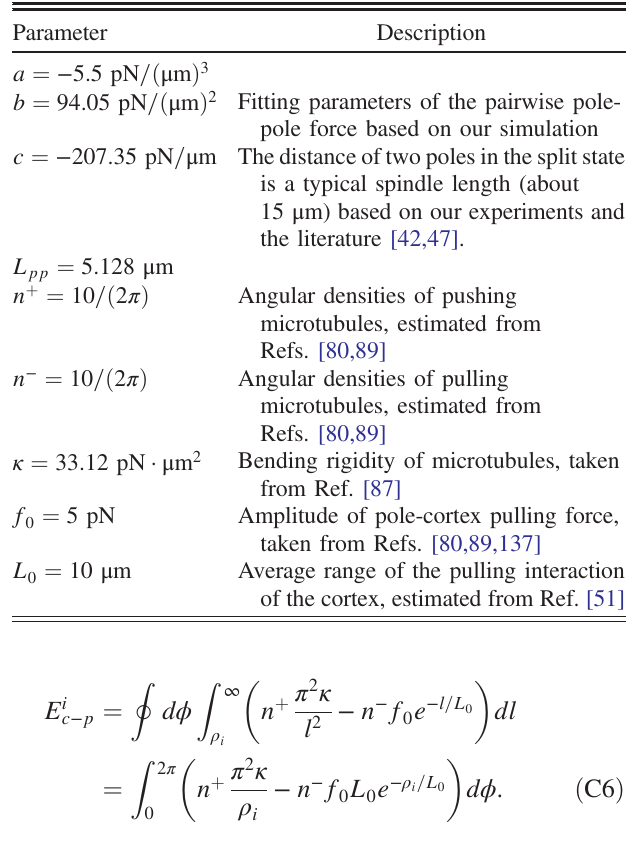
TABLE II. Parameters used in the theoretical